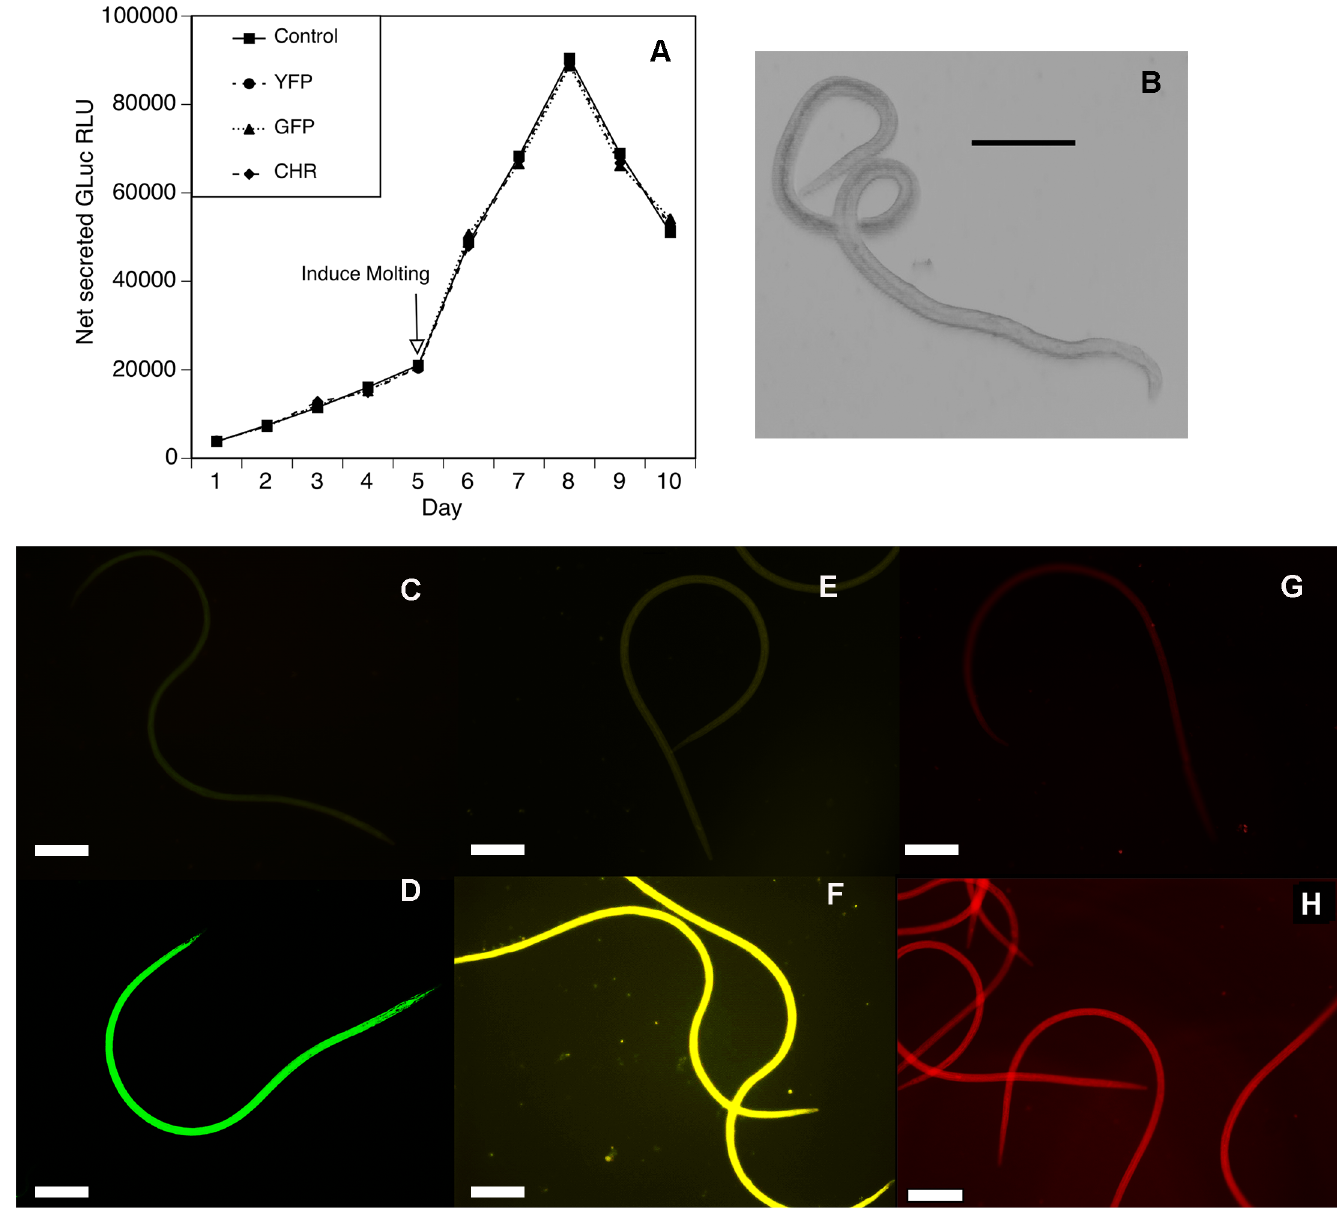
Fig 4. Secreted luciferase activity and fluorescent signal on L3 transfected with dual reporter plasmids. L3 were transfected with pBACII-BmGluc-MCS, pBACII-BmGluc-GFP, pBACII-BmGluc-YFP, or pBACII-BmGluc-CHR as described in the text. (A) Secreted luciferase activity in cultures of transfected larvae. The arrow indicates the day upon which molting was induced. Control = L3 transfected with pBACII-BmGluc-MCS, GFP = L3 transfected with pBACII-BmGluc-GFP, YFP = L3 transfected with pBACII-BmGluc-YFP and CHR = L3 transfected with pBACII-BmGluc-CHR. (B) Brightfield image of transfected parasites on day 8. (C) GFP channel florescence in the L3 transfected with pBACII-BmGluc-MCS. (D) GFP channel florescence in the L3 transfected with pBACII-BmGluc-GFP. (E) YFP channel florescence in the L3 transfected with pBACII-BmGluc-MCS. (F) YFP channel florescence in the L3 transfected with pBACII-BmGluc-YFP. (G) CHR channel florescence in the L3 transfected with pBACII-BmGluc-MCS. (H) CHR channel florescence in the L3 transfected with pBACII-BmGluc-CHR. In panels B-H bar =